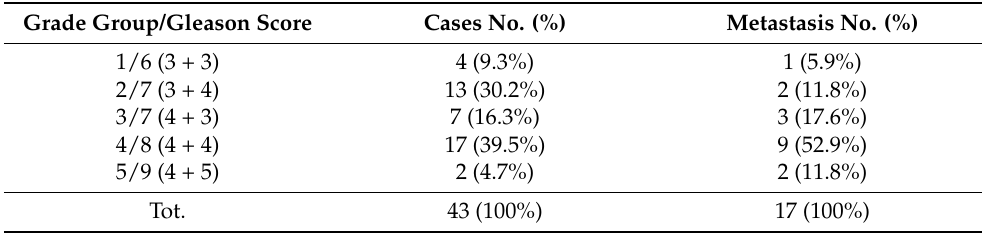
Table 1. Number of acinar prostatic adenocarcinomas divided at diagnosis by grade group and Gleason